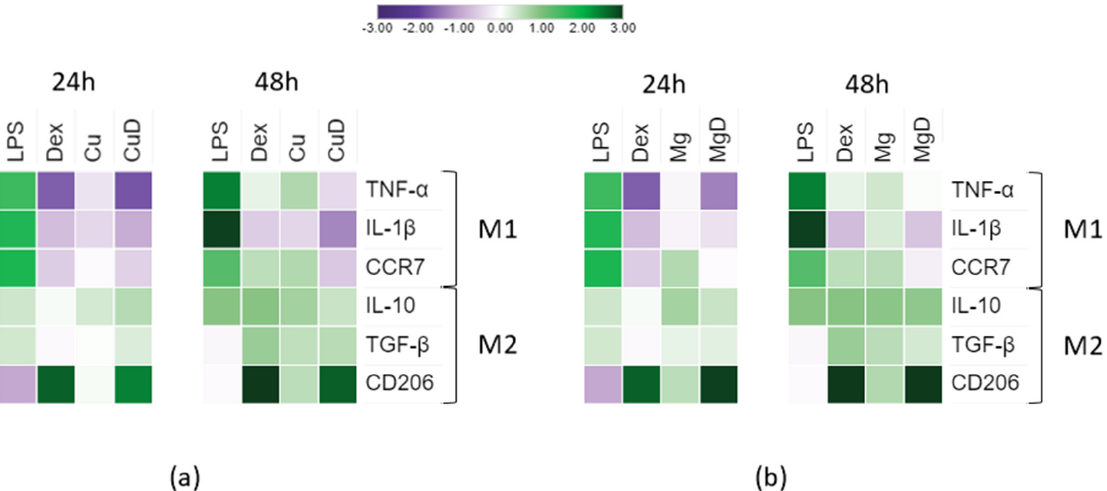
Figure 3. Effect of dex and the combination of dex with Cu 2+ and Mg 2+ on the expression of M1 and M2 markers in the THP-1 macrophage cell line. ( a ) Gene expression after incubating macrophages with Cu 2+ (Cu) and the combination of Cu 2+ with dex (CuD). ( b ) Gene expression after incubating macrophages with Mg 2+ (Mg) and the combination of Mg 2+ with dex (MgD). After 24 or 48 h of incubation, total RNA was extracted and the mRNA levels of three M1 markers (TNF- α , IL-1 β and CCR7) and three M2 markers (IL-10, TGF- β and CD206) were determined by RT-qPCR. Results were normalized against β -actin mRNA and are expressed relative to the mRNA levels of unstimulated THP-1 macrophages (TCP). The complete statistical analysis is in Tables S1–S6.